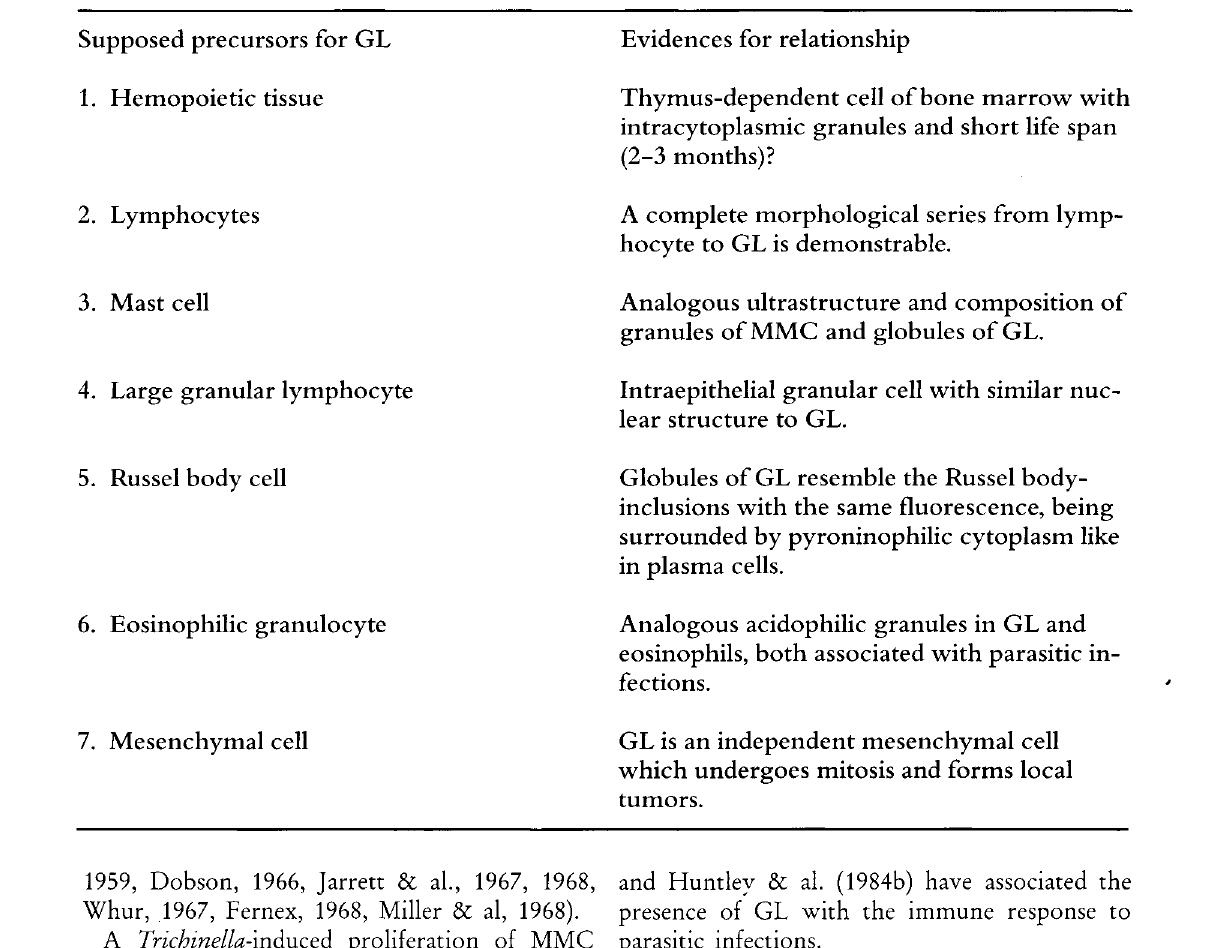
Table III. Theories and arguments on the origin and histogenesis of GL Supposed precursors for